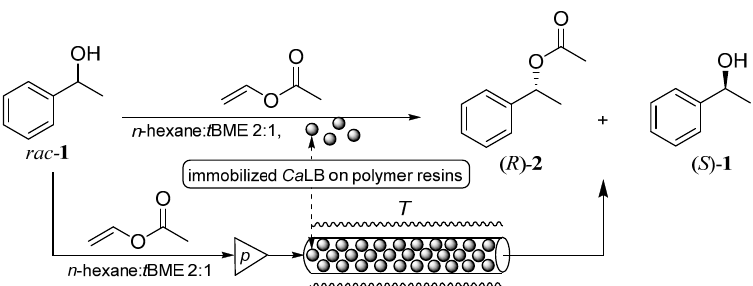
Figure 2. Kinetic resolution of racemic 1-phenylethanol ( rac - 1 ) catalyzed by covalently immobilized Ca LB preparations in batch mode and in continuous-flow reactor (for details of experiments see Sections 3.7 and 3.12). Table 2. Kinetic resolution of 1-phenylethanol ( rac - 1 ) catalyzed by Ca LB on bisepoxide-activated polymer resins (molar amount of bisepoxide 5 mmol ¨ g ´ 1 carrier) compared to the catalysis by Ca LB on